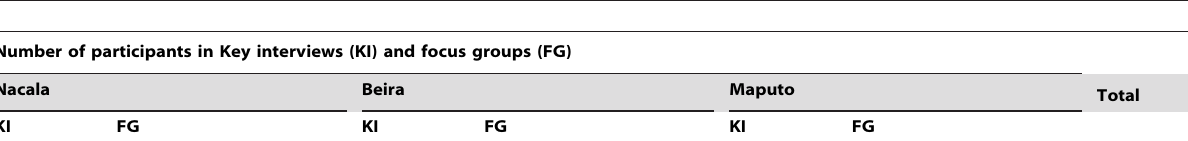
Table 1. Commercial sex-worker interviews and focus groups by study site, Mozambique, 2007–2008.